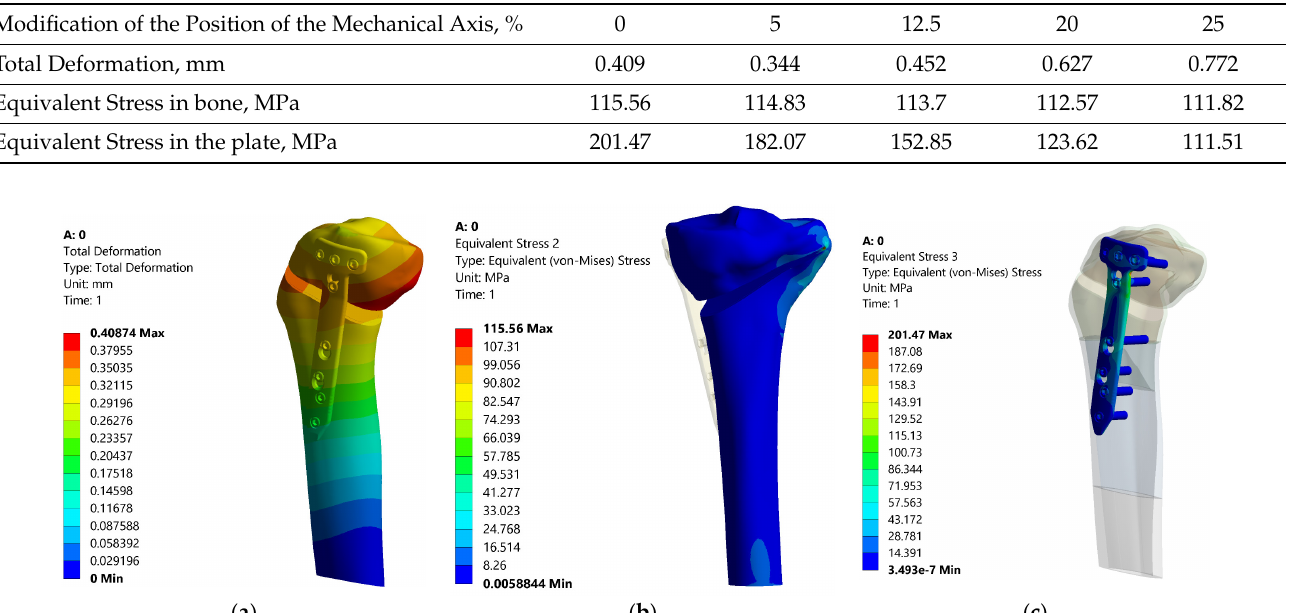
Figure 14. Distributions of the total deformation, equivalent stress in tibia and equivalent stress in the plate—12.5%.